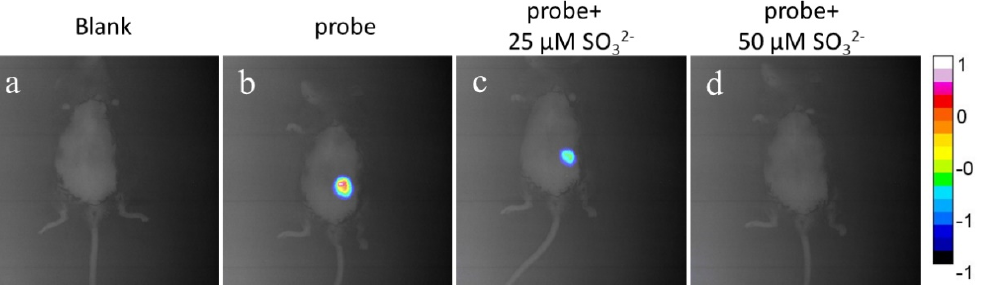
Figure 6. Fluorescence images of IPB-RL-1 in living mice. ( a ) Images of the mice only; ( b ) images after 100 μL of 50 μM IPB-RL-1 was injected into the mice for 5 min; ( c ) images after 100 μL of 25 μM SO 32− was injected into the mice for 5 min; ( d ) images after re-injection of 100 μL 50 μM SO 32- at the same location for 5 min (λ ex = 635 nm, λ em = 698 − 766 nm).